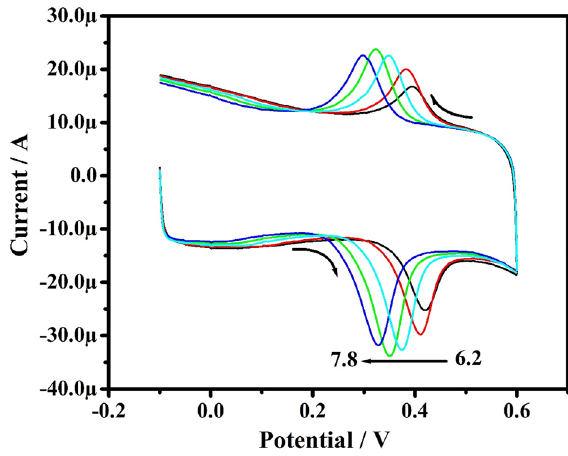
Figure 12. CVs for PA with varied pH at PoOCD/MCPE.